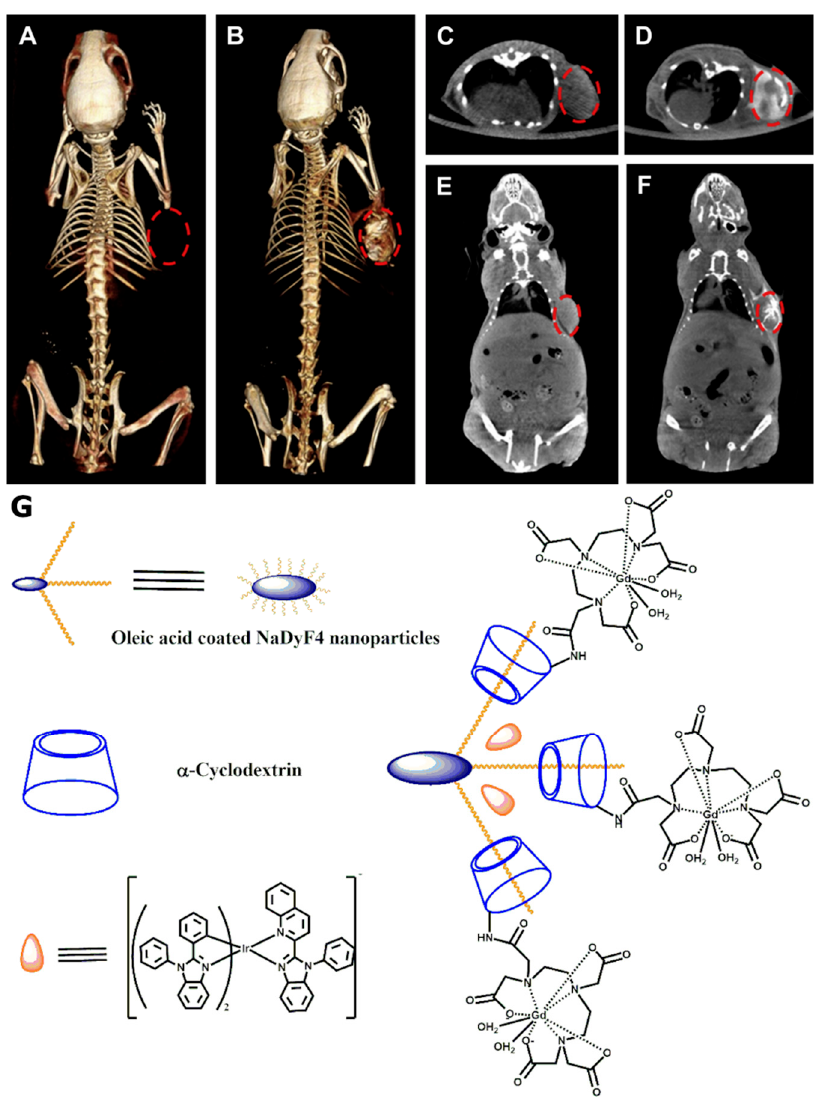
Figure 11. In vivo 3D volume-rendered ( A , B ) and maximum intensity projections in axial ( C , D ) and coronal ( E , F ) view CT images of the tumor-bearing mouse obtained pre- ( A , C , E ) and post- ( B , D , F ) injection of Ir-Gd- α -CD-DyNPs contrast agent [53]. The images are reprinted with permission from the publisher [53]. The position of the tumor was marked by red circles. The chemical structure of the developed CT contrast agent is shown in ( G ).